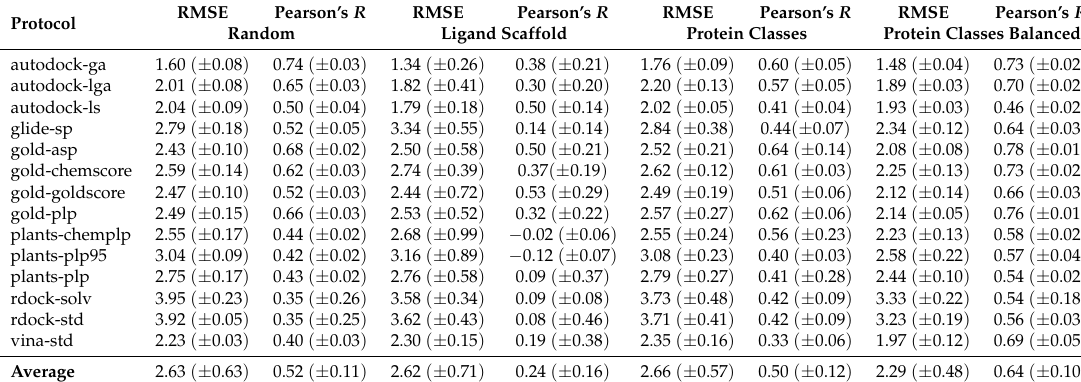
Table 1. Predictive performance for RMSD ave ( splits